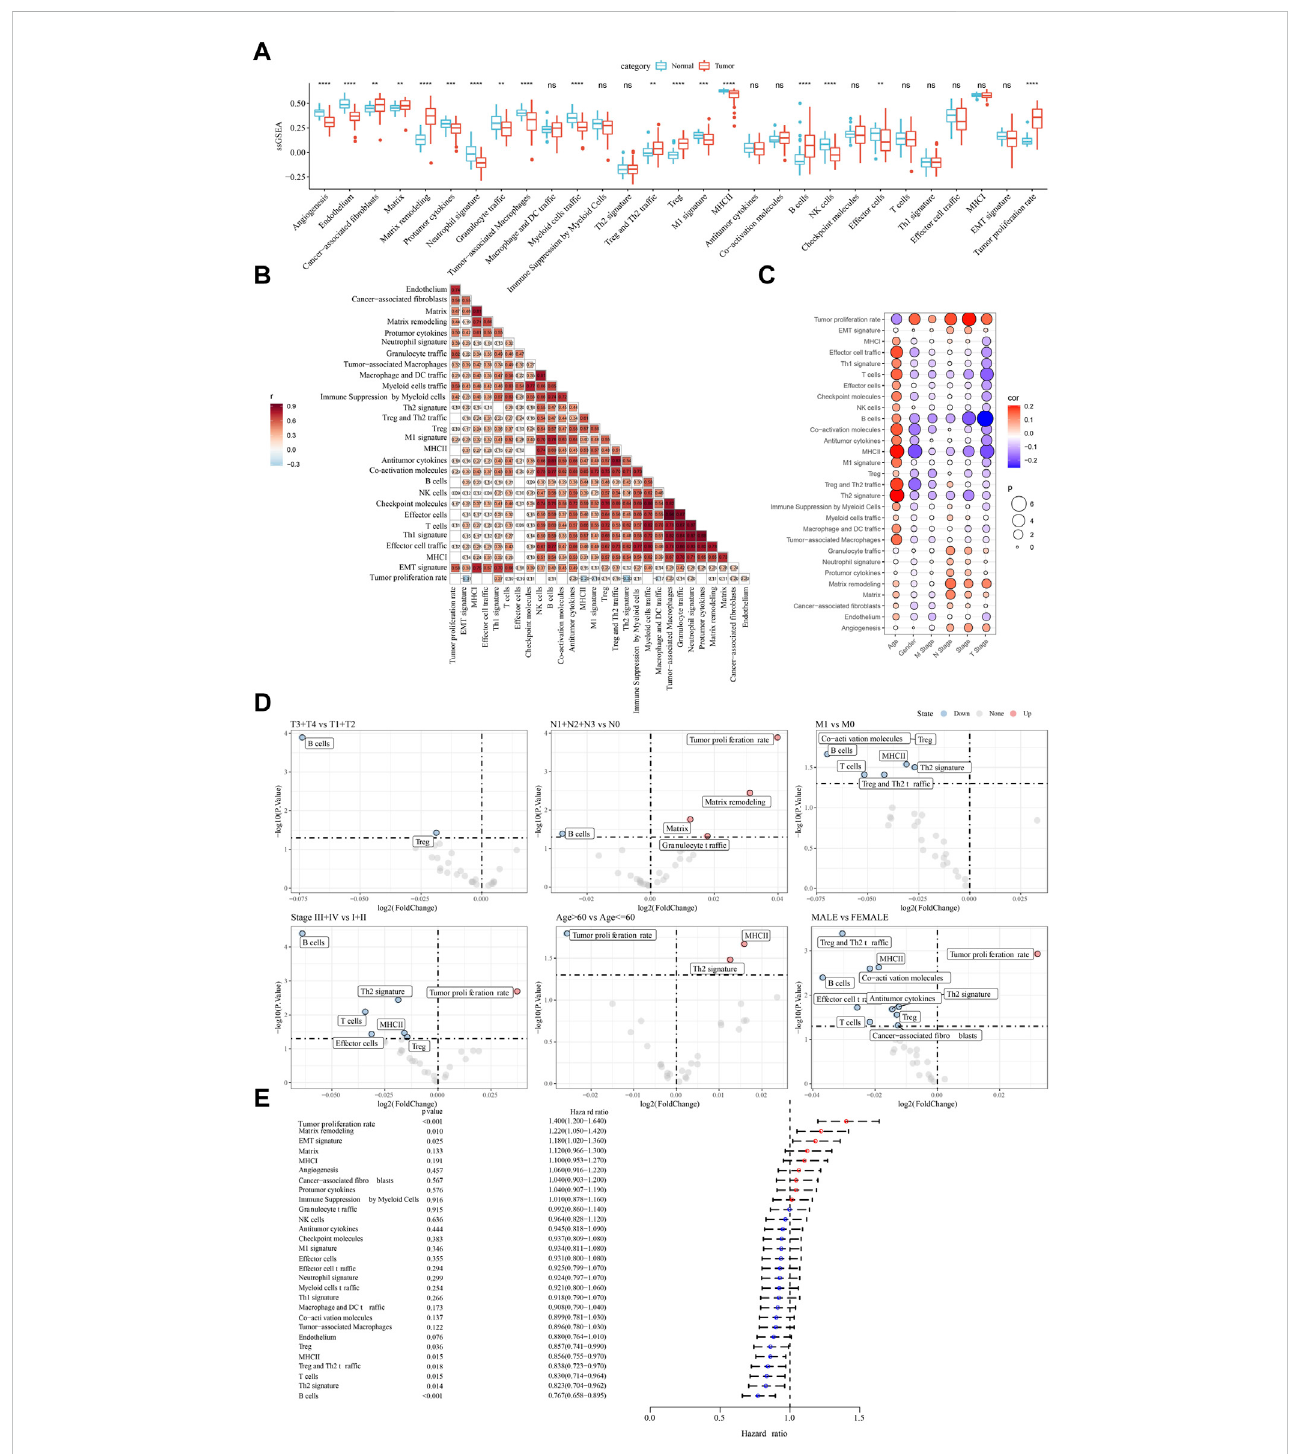
FIGURE 1 The relation between TME signatures and LUAD analyzed in TCGA dataset (A) The ssGSEA score of TME signatures in tumor and normal samples (B) Correlation analysis among TME signatures (C) Correlation between TME signatures and clinical characteristics (D) Fold change of the enrichment of TME signatures in different stages, ages, and genders (E) Hazard ratio of 29 TME signatures. ns, not signi fi cant. ** p < 0.01, *** p < 0.001, **** p <